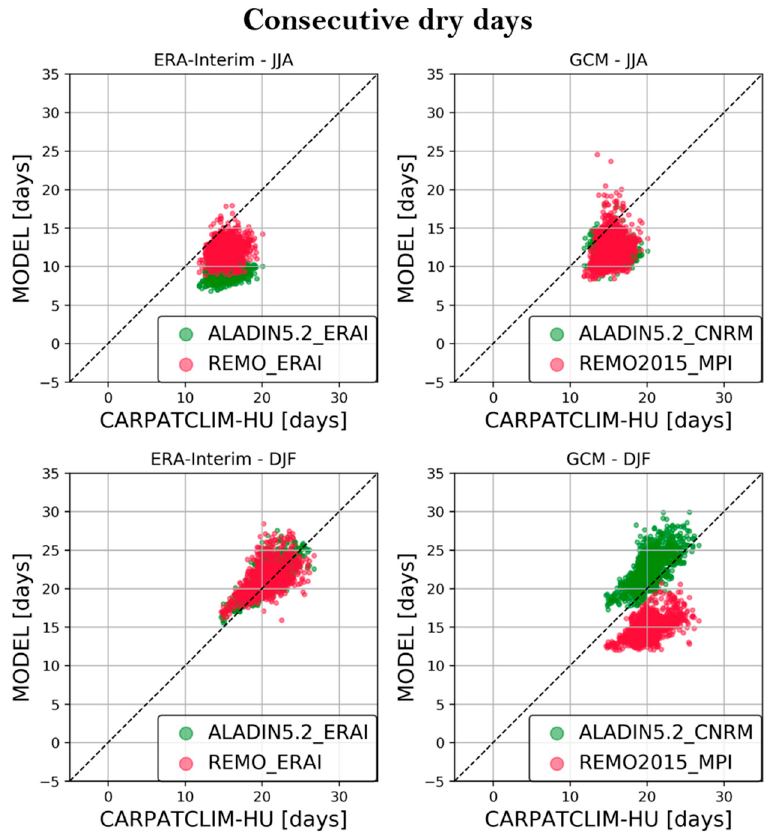
Figure 7. Mean values of consecutive dry days in summer and winter for 1981–2000 based on the CarpatClim-HU observation dataset ( x -axis) and the RCM simulations ( y -axis). Each dot represents the value of one grid point over Hungary.